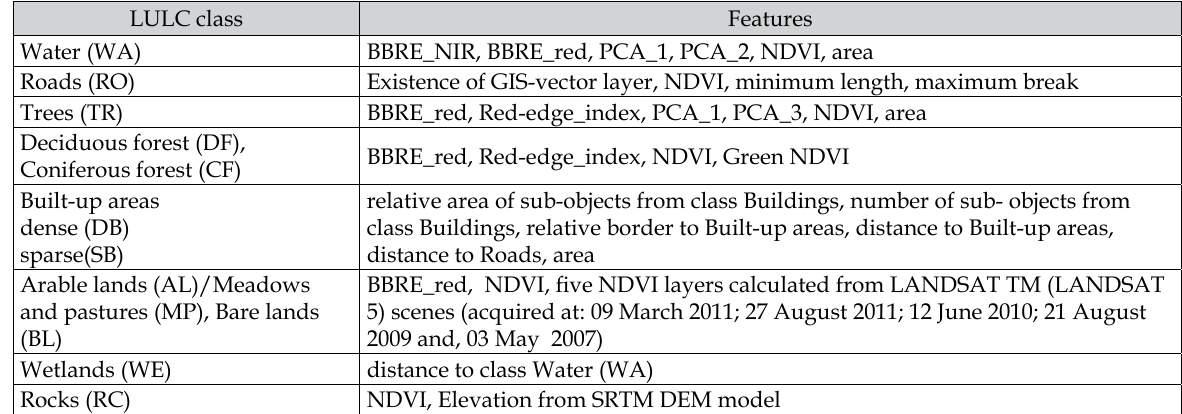
Table 1. the most useful features identified and used in the GeoBia workflow. LULC class